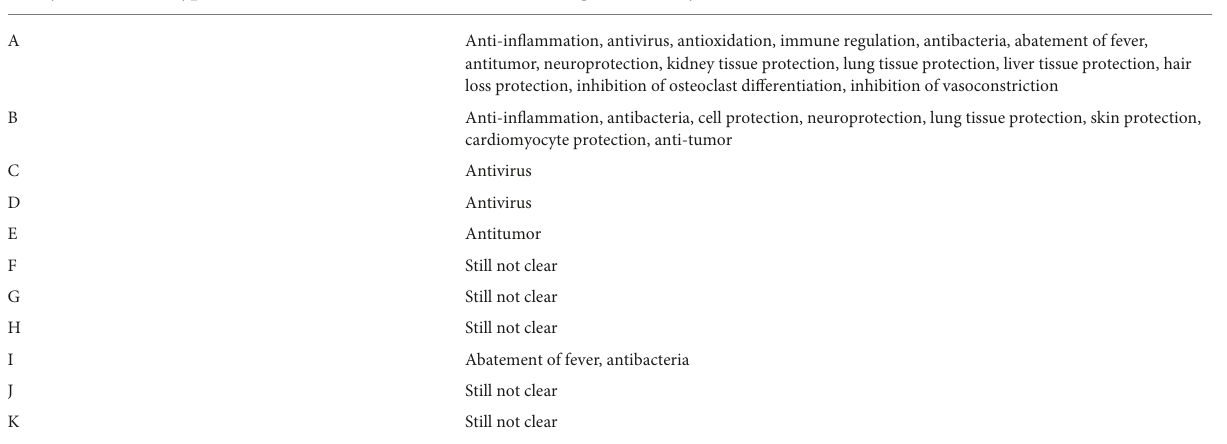
TABLE 4 Pharmacological activities of